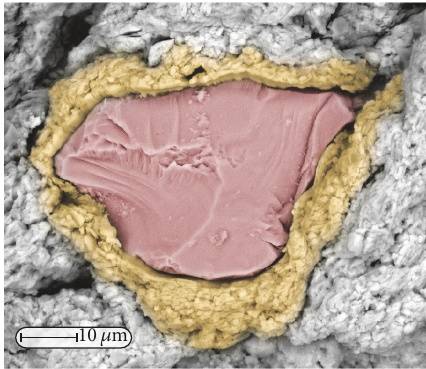
Figure 3: Kaolinite clay coating (in yellow) on the surface of the quartz grain (in